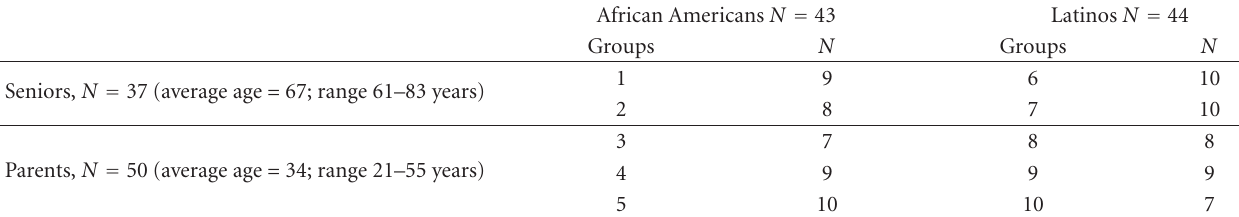
Table 1: Focus group composition.